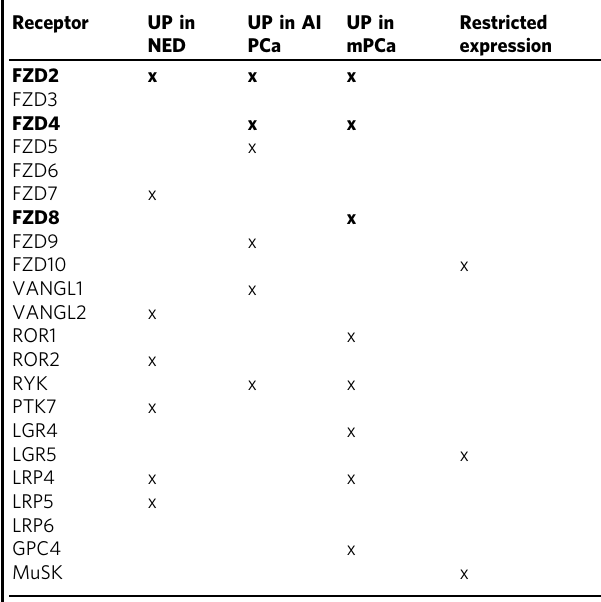
Note : Summary of Wnt receptor mRNA expression in prostate cancer (PCa) cell lines with x denoting expression in lines with features of neuroendocrine-like differentiation (NED), androgen-independence (AI), capacity for metastasis (Met) and restricted expression to one line (RE) (for details see Supplementary Fig. 1); FZD2, FZD4 and FZD8 (highlighted in bold) were highly expressed in cells with more aggressive features of PCa; FZD1 was not